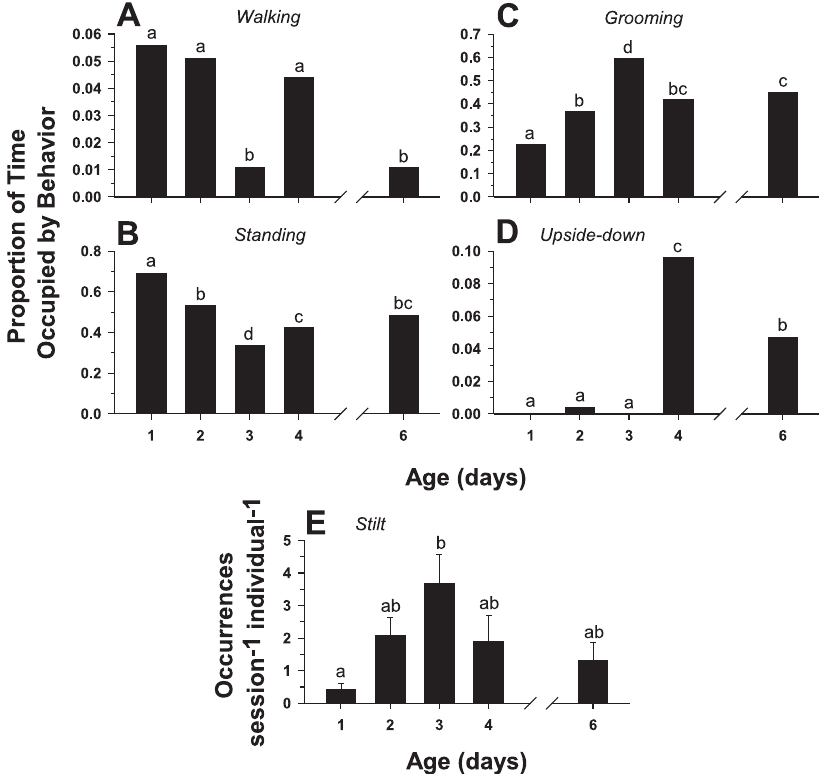
Figure 13. Ontogeny of behavior in the single male flies. Changes in the proportions of total observation time, with respect to age (in days), occupied by each of the four most predominant behaviors (see Table 1 for descriptions) in the individual fly experiments (A) walking , (B) standing , (C) grooming , and (D) upside-down . Also shown are changes in the frequency of occurrence of the behavior stilt (E), calculated as the number of occurrences hour 2 1 individual 2 1 . Vertical bars indicate means 6 s.e.m. Different letters above the bars indicate significant differences.